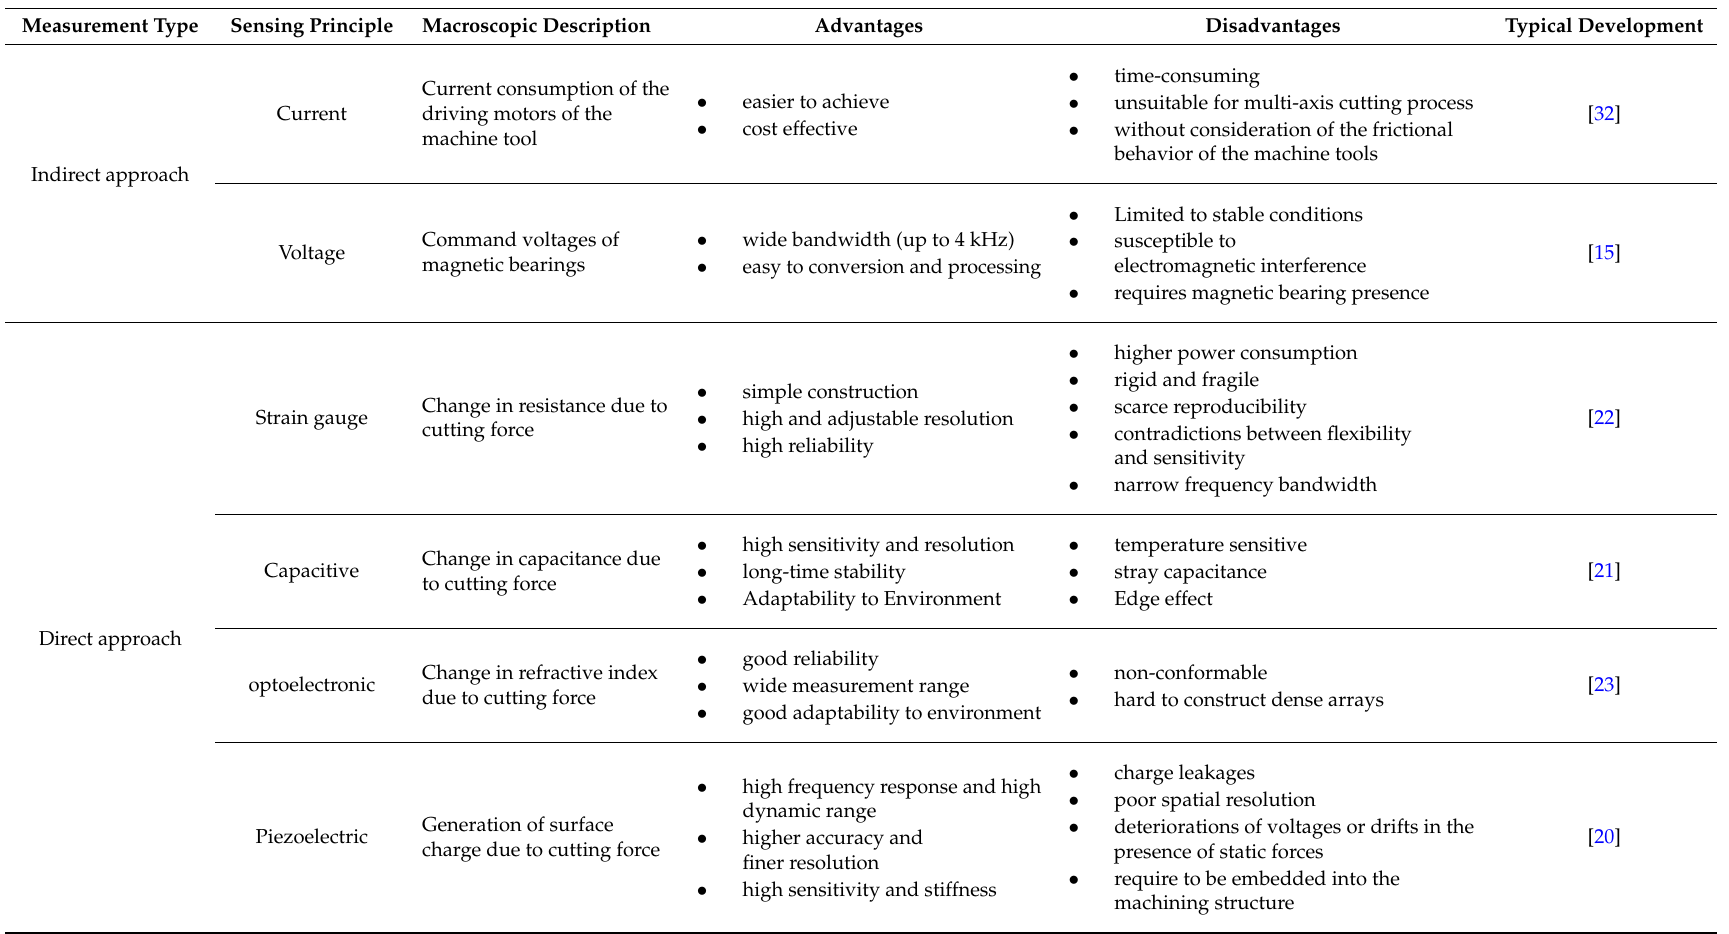
Table 1. Intrinsic transduction techniques for cutting force measurement